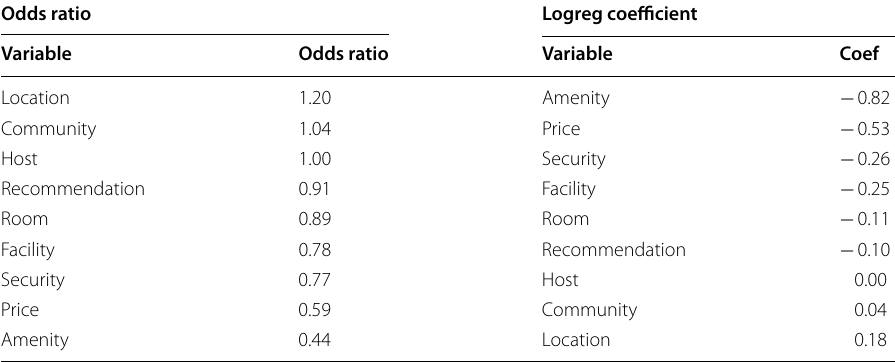
Table 15 Odds ratio and logreg coefficient for topics prediction Odds ratio Variable